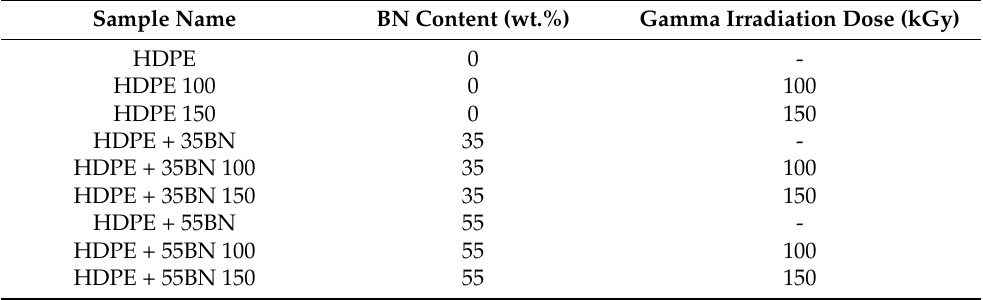
Table 1. List of rectangular specimens prepared with different BN content and irradiation dose.